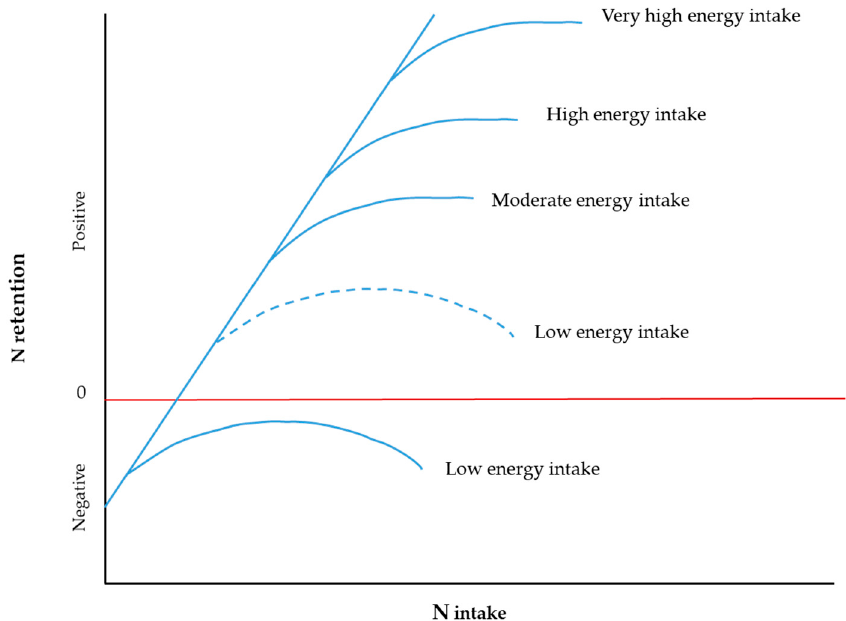
Figure 4. N retention response (linear blue slope) to varying energy:protein intake. The continuous lines represent the situation in the Balch model and the dashed curve “Low energy intake” denotes the more likely situation. The red line denotes zero nitrogen retention. Adapted with permission from [81].